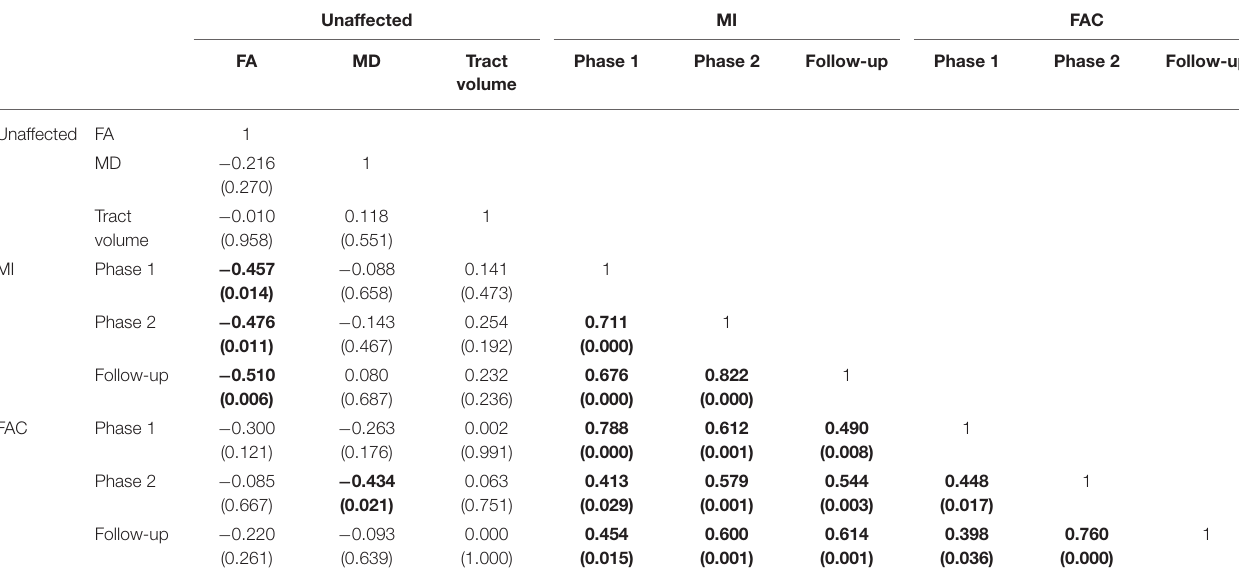
DTI, diffusion tensor imaging; PIVC, parieto-insular vestibular cortex; Unaffected, unaffected hemisphere; MI, motricity index; FAC, functional ambulatory category; Phase 1, start of rehabilitation; Phase 2, end of rehabilitation; Follow-up, follow-up 6 months after onset; FA, fractional anisotropy; MD, mean diffusivity. Values represent Spearman correlation coefficient (p value). Correlations significant at p < 0.05 are in bold (uncorrected).